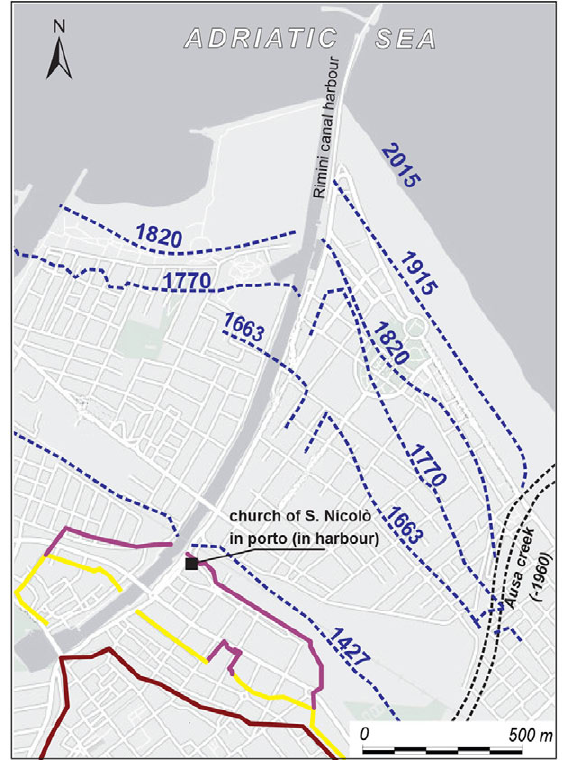
Fig. 3. Coastal advance since the XV century in the harbour sector of the Rimini site. Solid colour lines: historical town walls, symbols on Fig.